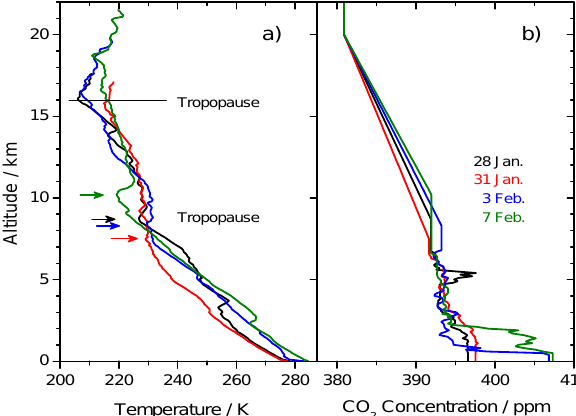
Fig. 6. Time series of column density and x CO 2 with the stan- dard deviations at JAXA in Tsukuba, Japan. OSA: solid cir- cles (SF=1.008); FTS: open circles (SF=0.989); Aircraft: open squares.